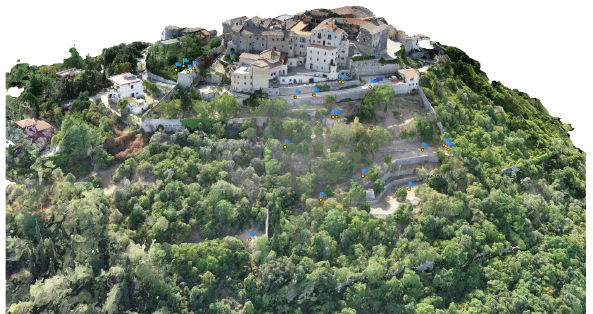
Figure 7 . Tiled model of the survey